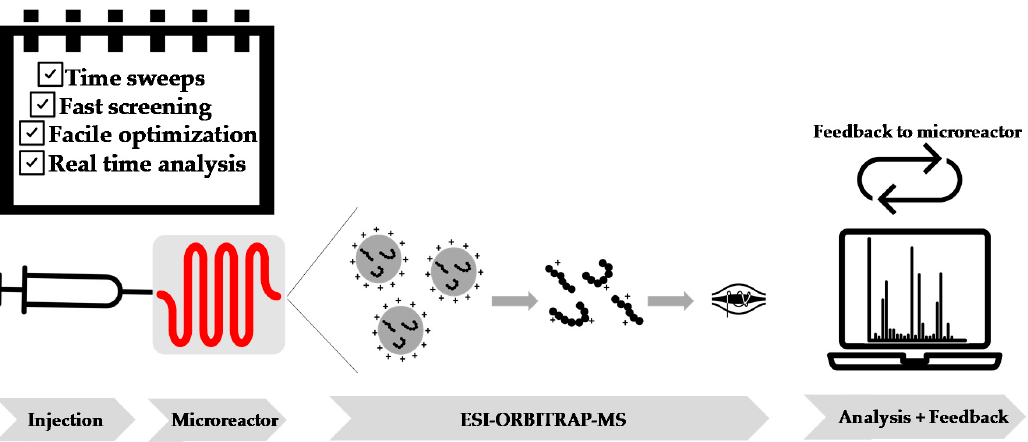
Figure 1. Schematic representation of the online microreactor/mass spectrometry setup applied for the monitoring of reversible addition-fragmentation chain transfer (RAFT) polymerization processes.